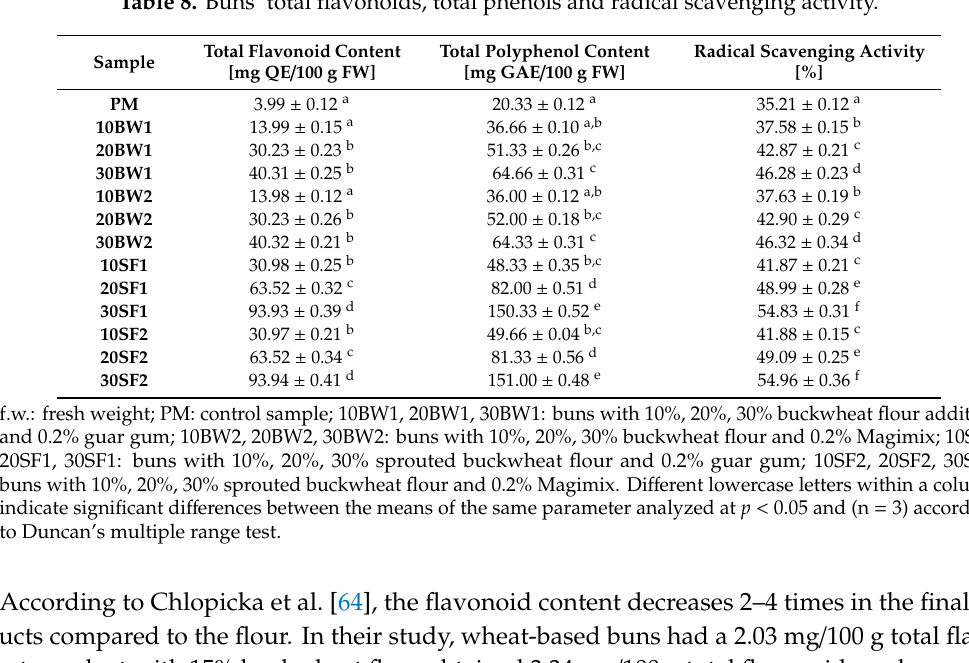
Table 8. Buns’ total flavonoids, total phenols and radical scavenging